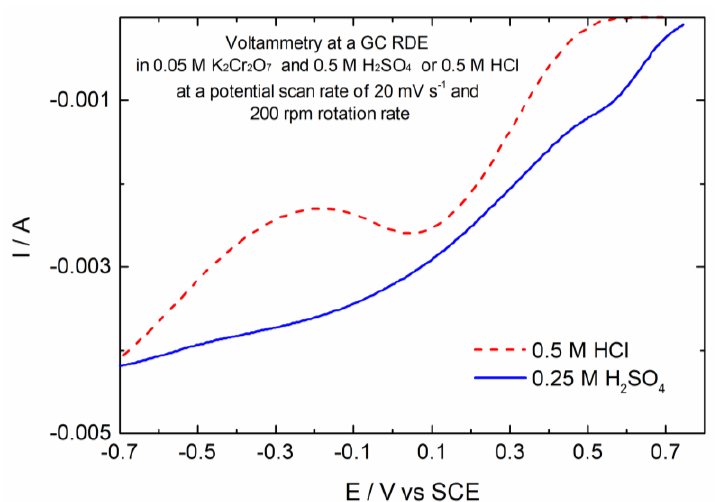
Figure 5. Current vs. potential linear sweep voltamogram (LSV) curves, recorded with the use of a